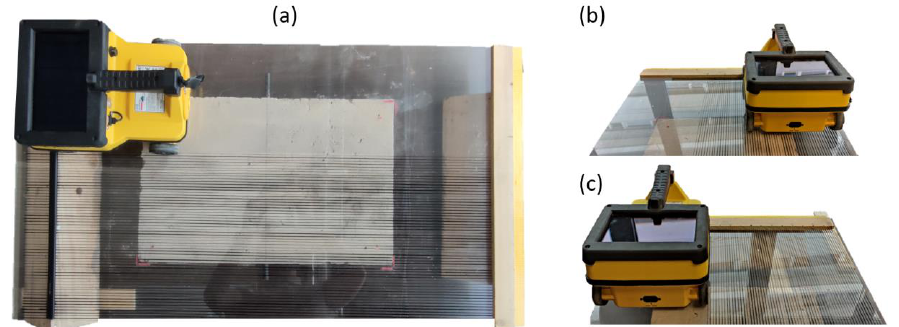
Figure 4. GPR acquisition system and the plexiglass plane where several lines were depicted in order to make all the radargrams in the same position. ( a ) Image from the top; image from behind the antenna where the first ( b ) and the last ( c ) profiles were carried out.